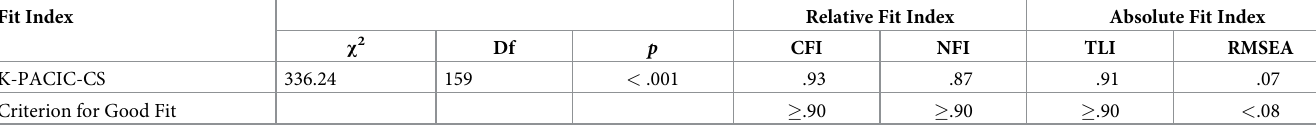
Table 3. Model fit of confirmatory factor analysis of the K-PACIC-CS (N =